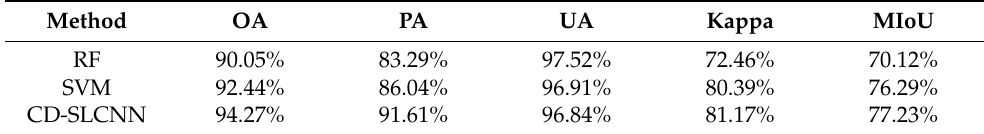
Table 3. Quantitative analysis of the CD-SLCNN results of Sentinel-2